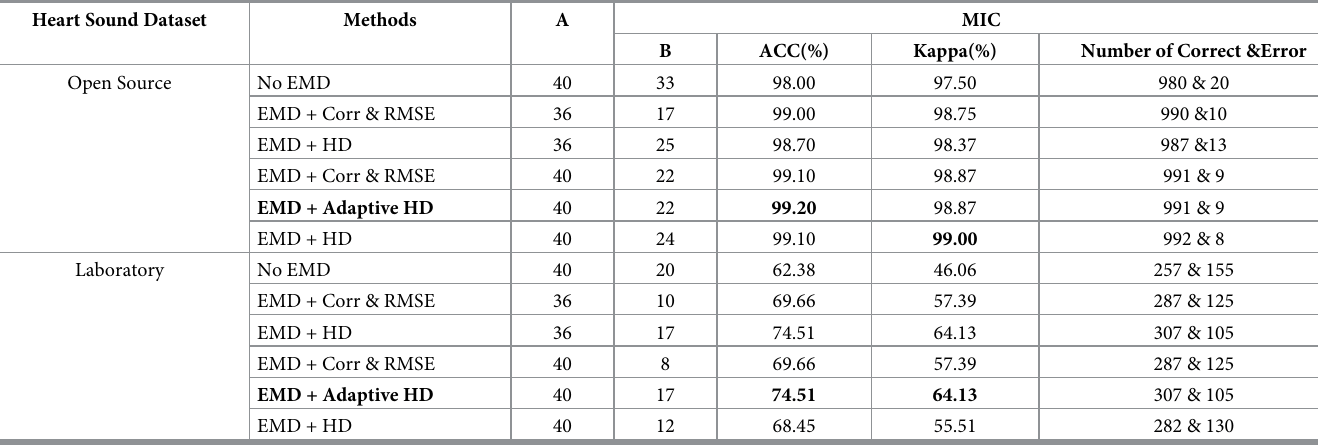
Table 7. Comparison of accuracy and feature dimension under different methods based on MIC. Heart Sound Dataset